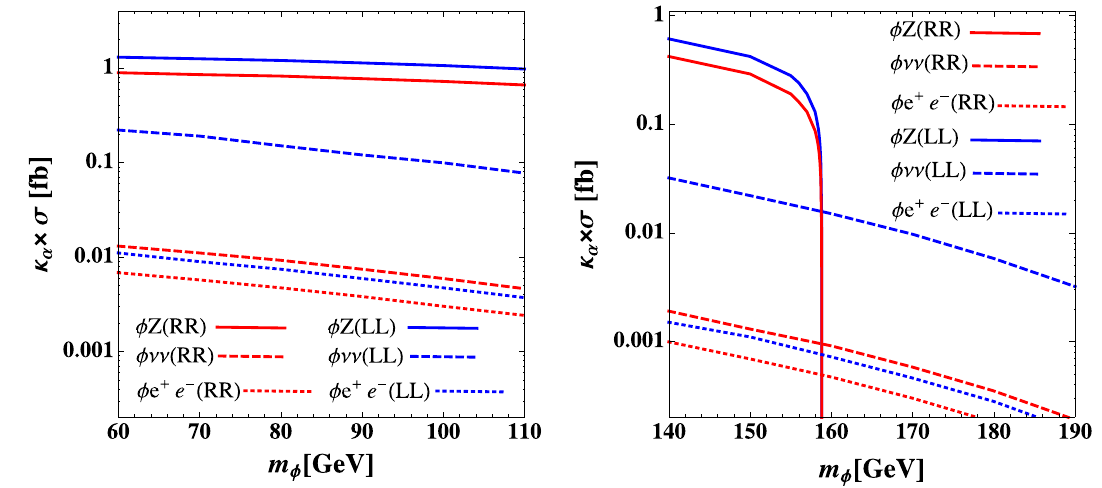
Fig. 5 The cross section for φ production processes in e + e − collider for two polarization cases LL and RR as a function of m φ . The scaling factor κ α = ( 0 . 05 / sin α) 2 is multiplied with the cross section